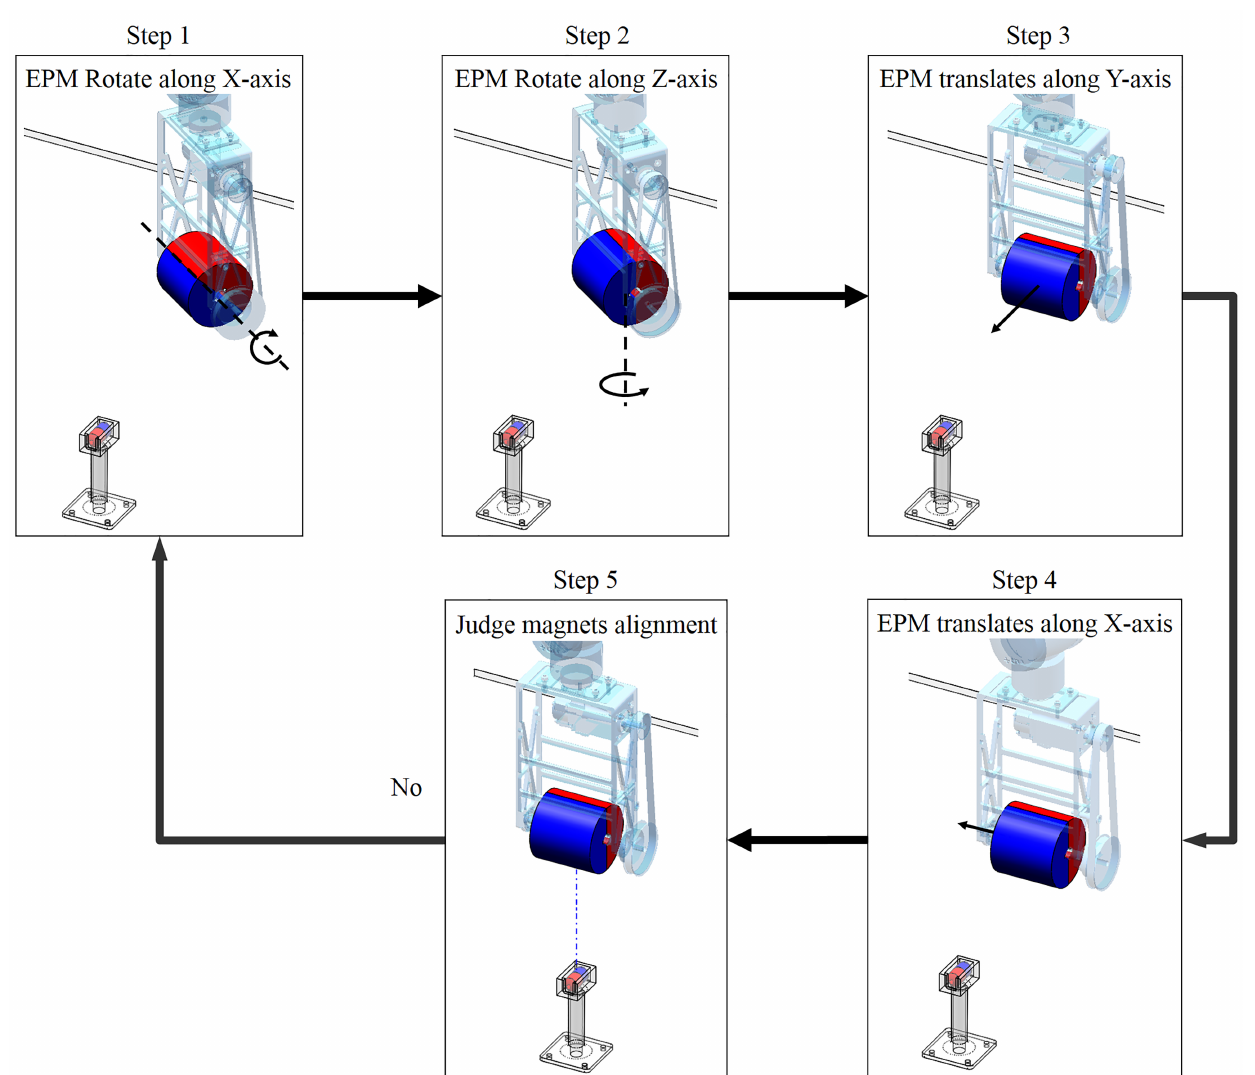
Figure 9. Control method used to realign the EPM and the IPM to prevent loss of the magnetic